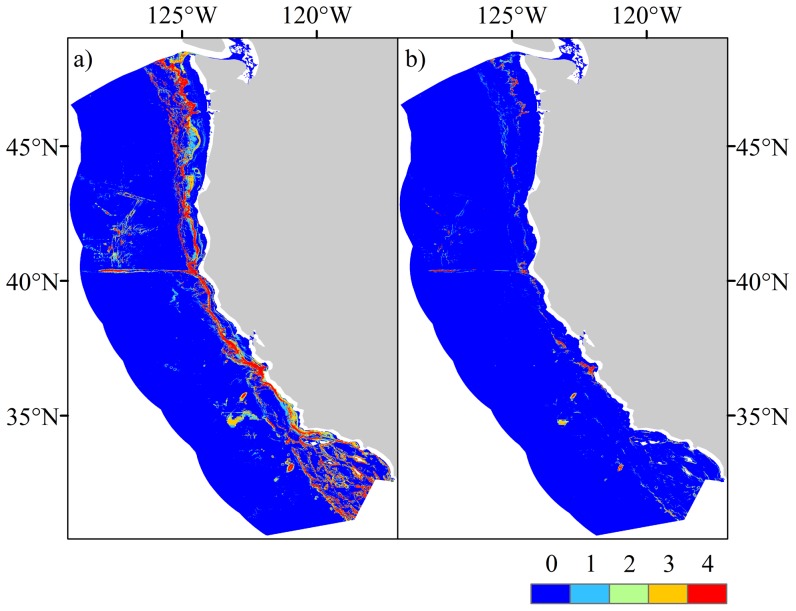
Predicted habitat suitability for all taxa.a) 0.5 threshold as per the previous figures, b) 0.75 threshold. The higher threshold greatly constrains the output, producing predictions that are more focused on areas of the highest suitability.